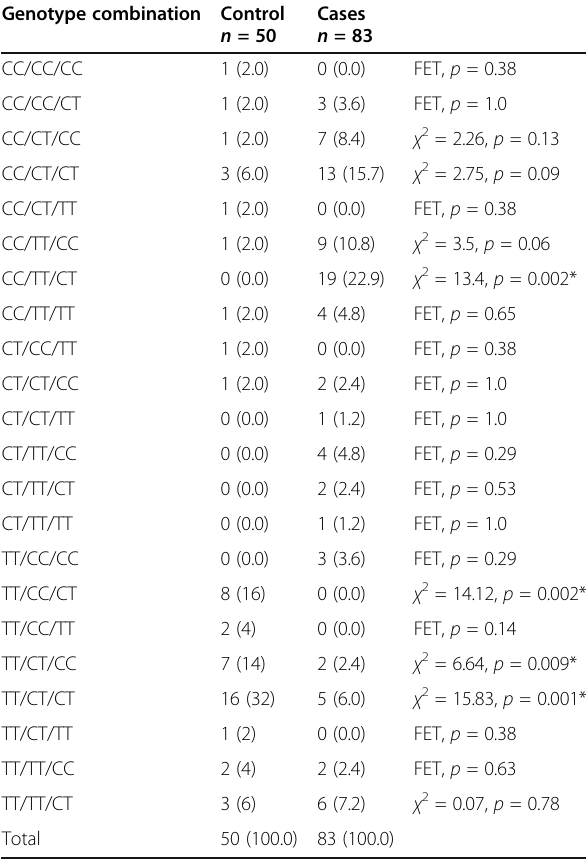
Table 12 Genotype combination among studied cases and control